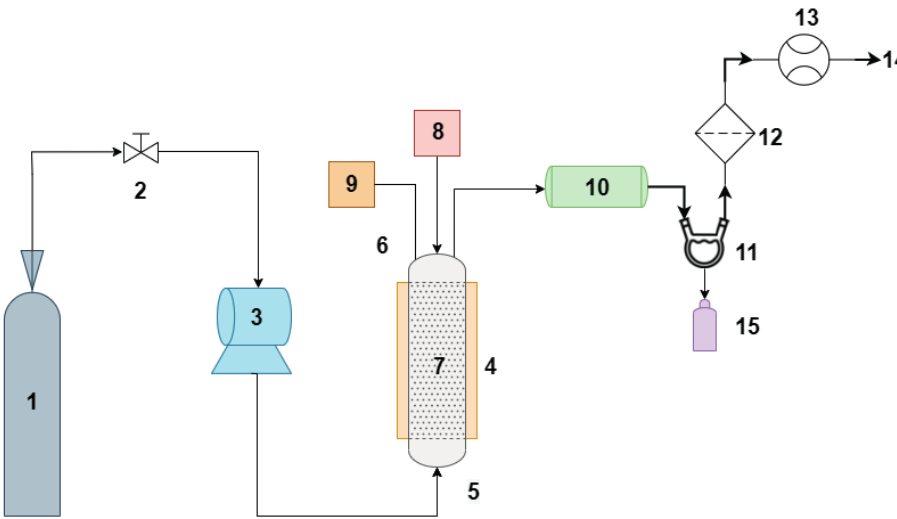
Fig. 1. Set up of the slow pyrolysis used for the production of bio-char. (1) nitrogen gas tank, (2) flow controller, (3) gas heater, (4) furnace with electrical tubes, (5) char collector, (6) pyrolysis reactor, (7) biomass bed, (8) biomass lock hopper, (9) Thermocouple (10) condenser, (11) condensation & gaseous separator, (12) filter, (13) gas flow meter, (14) gas output (15) extracted bio‐oil. The bio-char obtained from the pyrolysis process was further converted into activated carbon by using ZnCl 2 as activating agent. For this, powdered ZnCl 2 and coffee residues